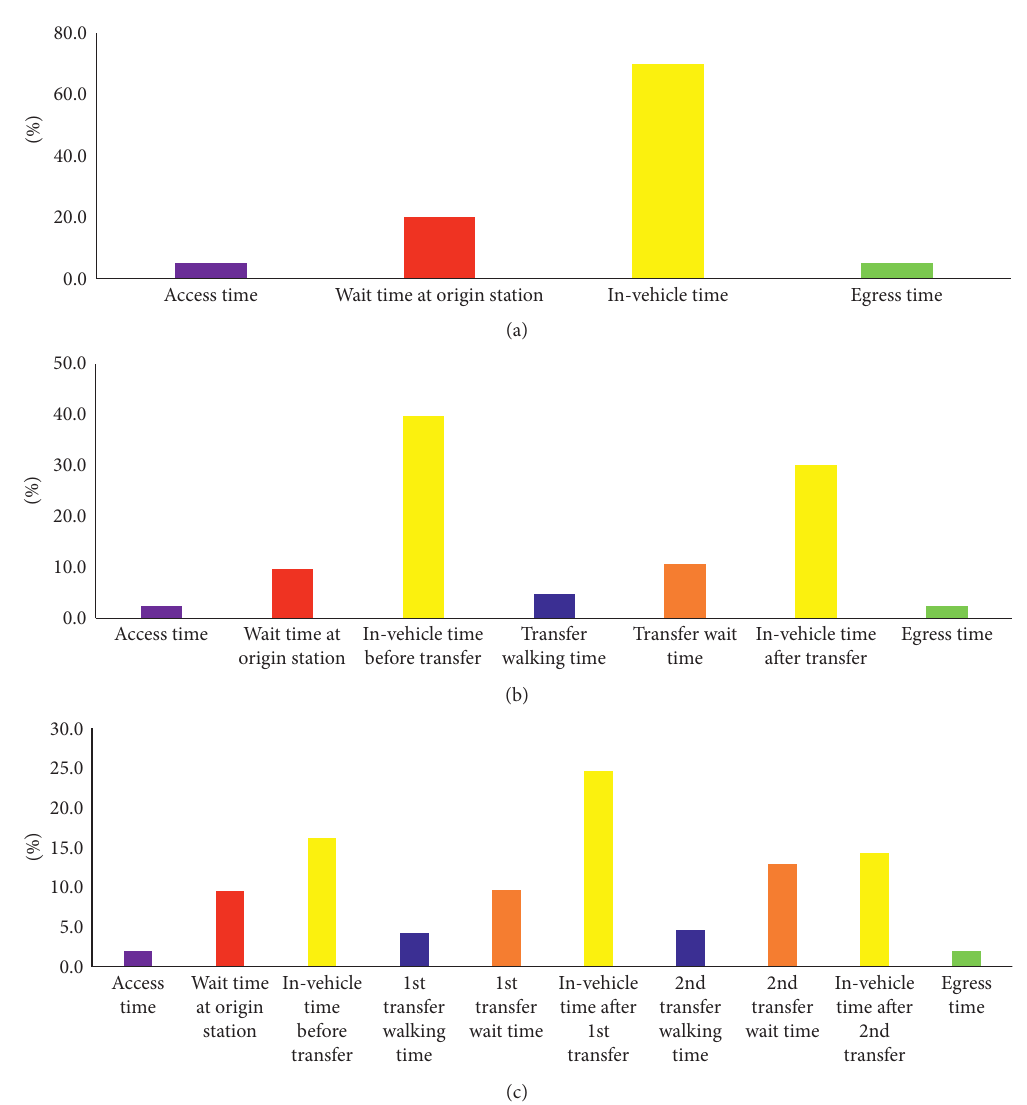
Figure 5: Passenger flows at stations during AM peak. (a) Entry pass. (b) Exit pass.